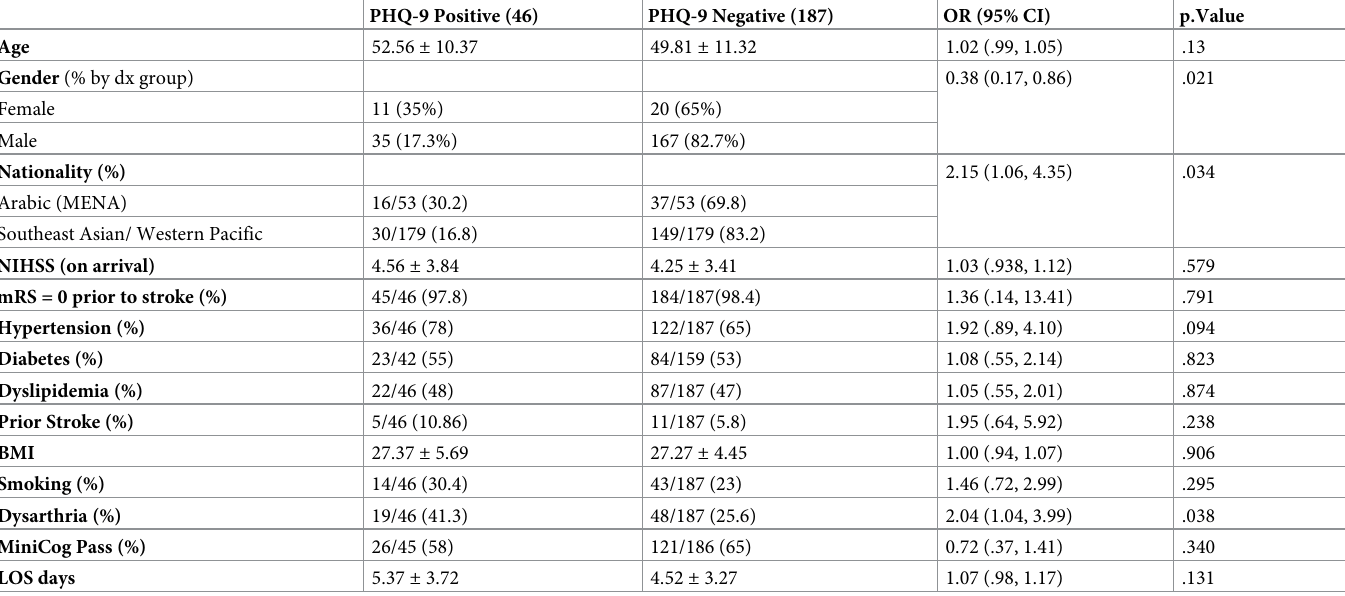
Table 1. Demographic and clinical factors and PHQ-9